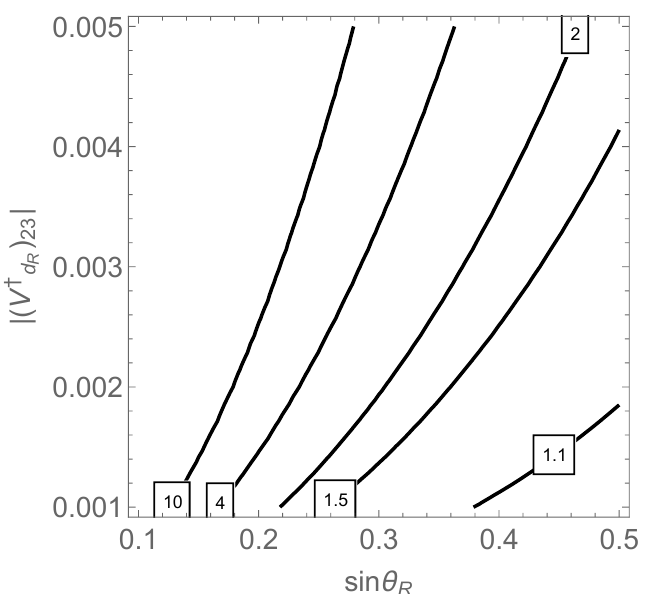
) 23 consistent d R